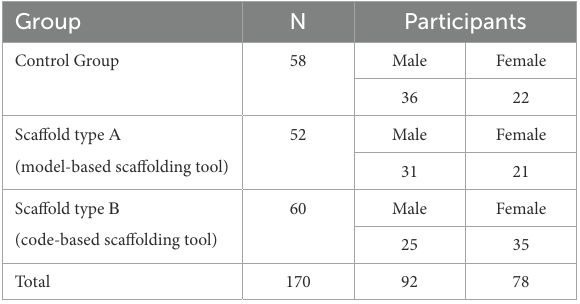
TABLE 1 Number of students, gender, and type of scaffolding tool per research group.